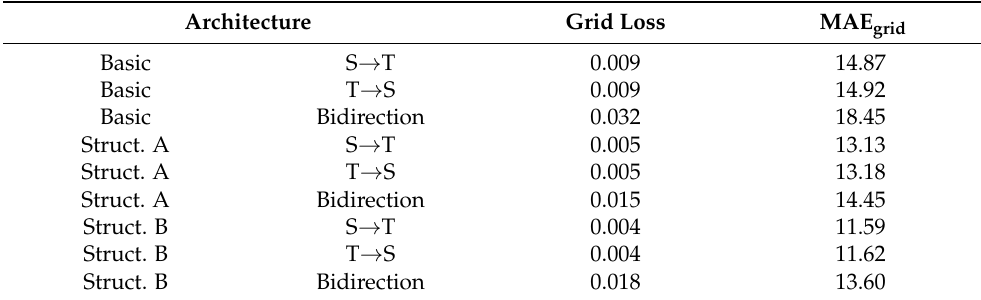
Figure 11. Comparison of different architectures. ( a ) shows the trends of training loss and ( b ) shows the trends of MAE grid with the training process. Table 5. Comparative results of different architectures and inference procedures on validation set. “S → T” and “T → S” indicate the predicted transformations in two inference directions of the same trained model. “Bidirection” refers to the two-stream model trained bidirectionally and as an